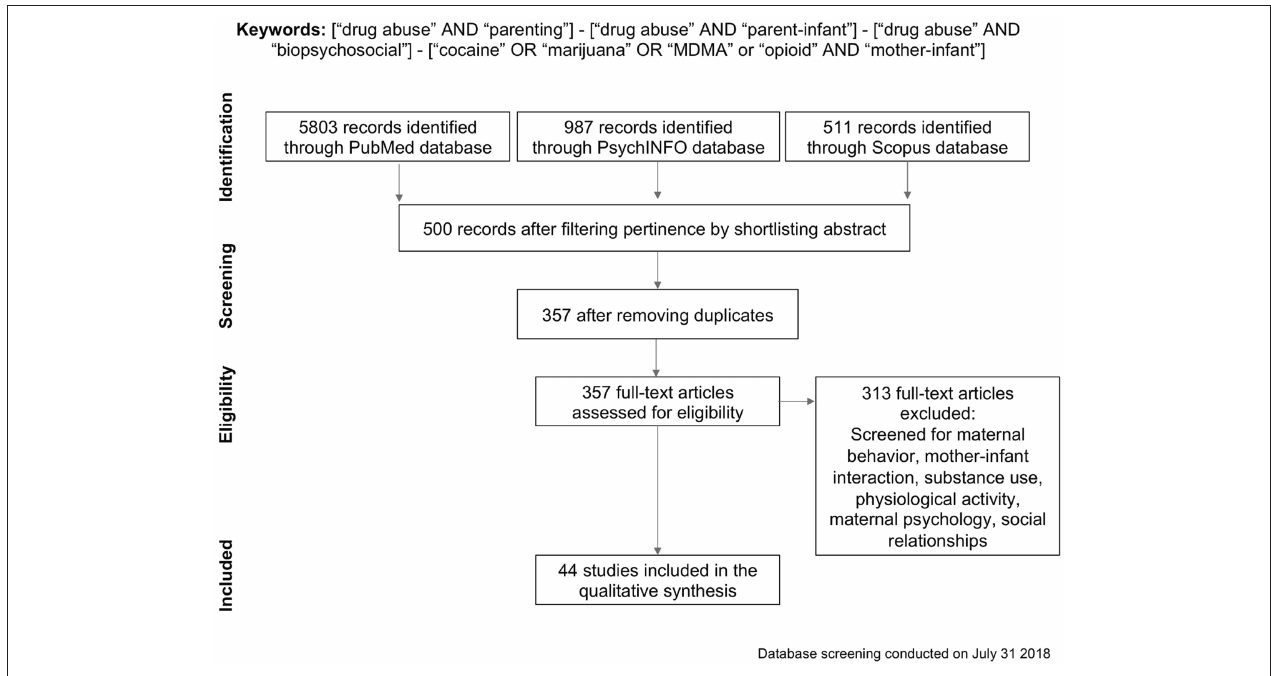
FIGURE 1 | PRISMA flowchart for search criteria and papers eligibility.